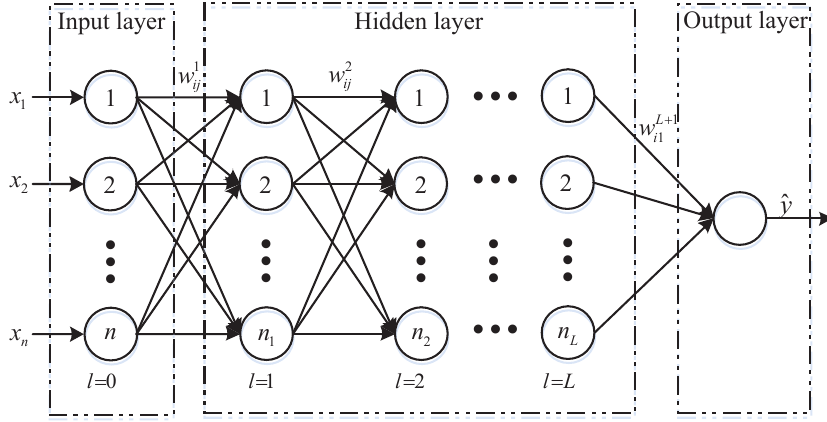
Figure 5. The structure of BPNN with L hidden